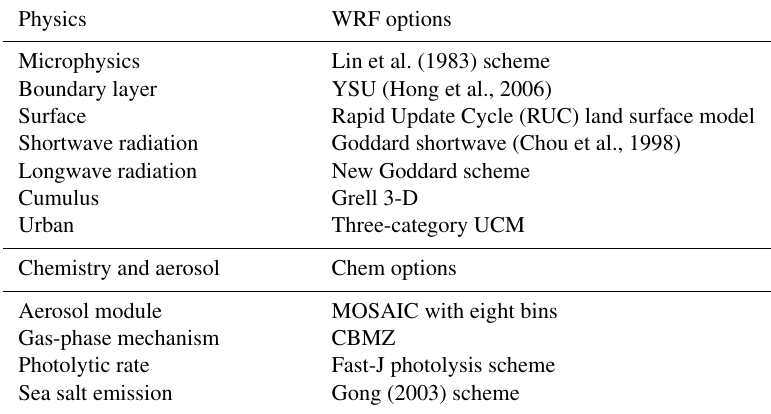
Table 1. Configurations of